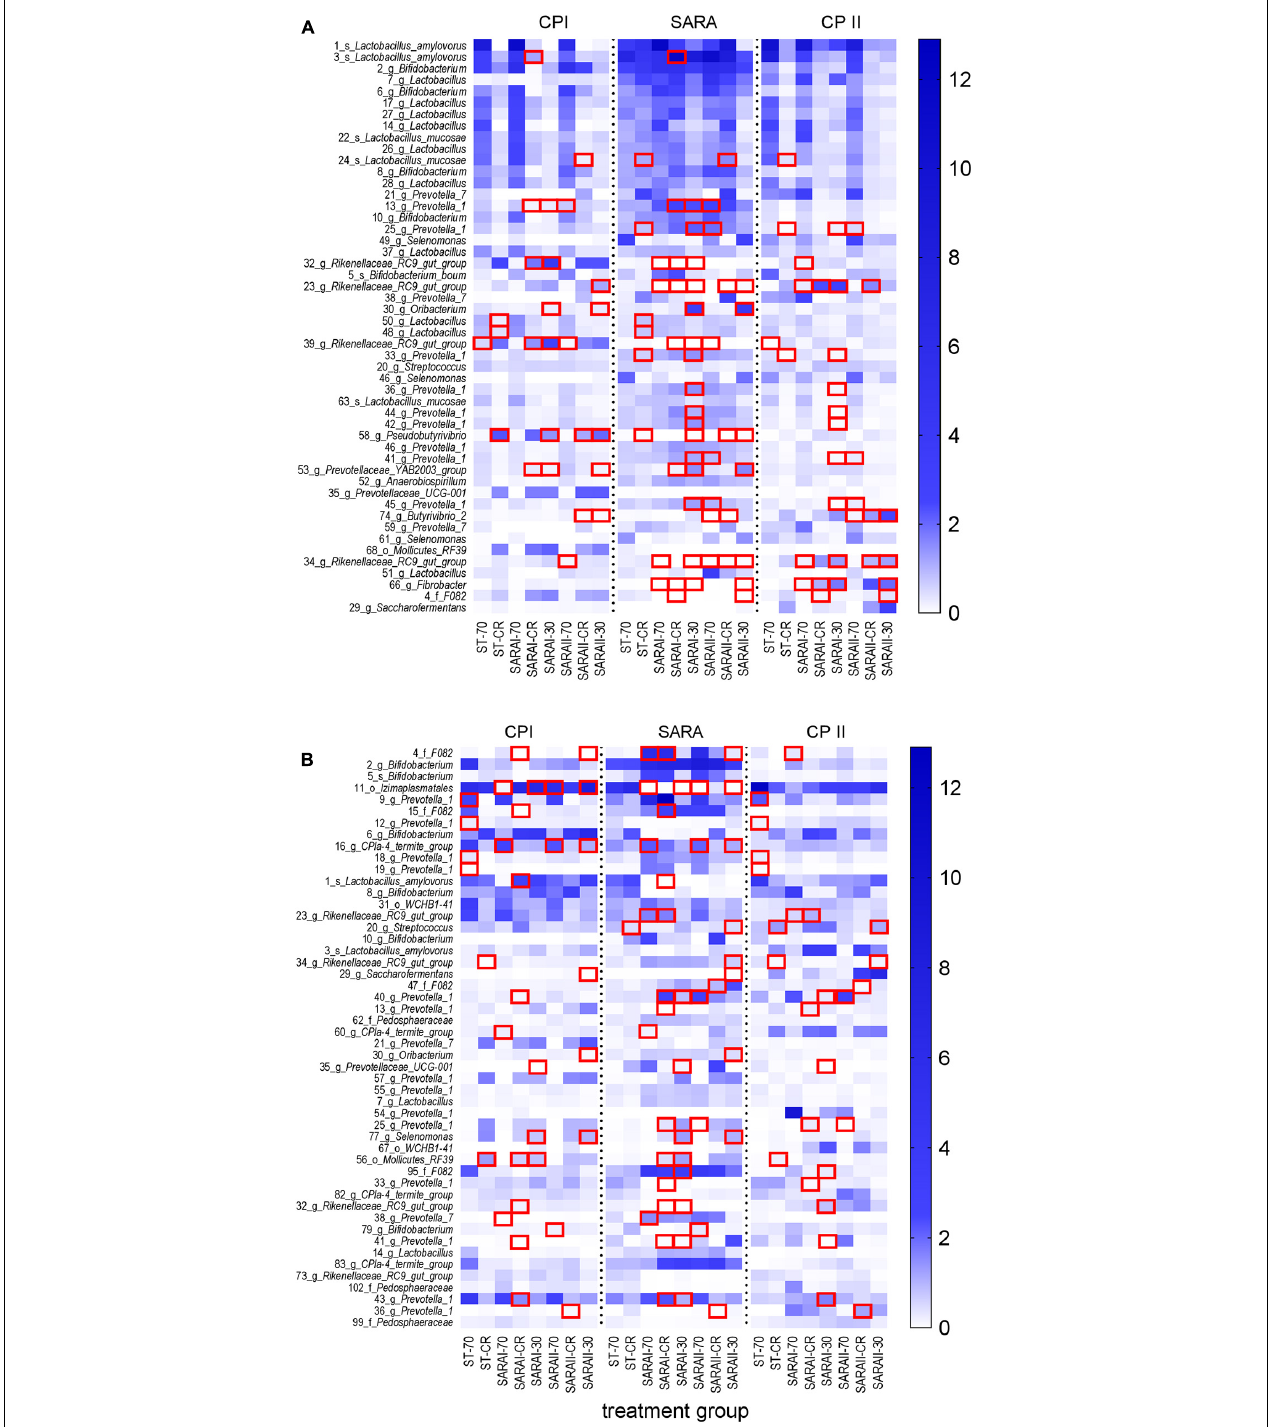
FIGURE 8 | Alterations of the 50 most abundant amplicon sequence variants (ASV) in the PacBio analysis throughout all experimental periods (left: CP I = control period I, middle: AP = acidosis period, right: CP II = control period II) for the solid (A) and liquid (B) phases. ASVs are labeled with the ASV-number, followed by the lowest classification level ( o = order, f = family, g = genus, s = species) and the taxonomic identification. Samples of all four runs were statistically analyzed and are labeled as follows: ST-70 = standard buffer, 70% concentrate; ST-CR = standard buffer, changing ratio; SARAI-70 = SARA I buffer, 70% concentrate; SARAI-30 = SARA I buffer, 30% concentrate; SARAI-CR = SARA I buffer, changing ratio; SARAII-70 = SARA II buffer, 70% concentrate; SARAII-30 = SARA II buffer, 30% concentrate; SARAII-CR = SARA II buffer, changing ratio. The relative abundance (%) is indicated by the color scale. Significant changes of ASVs throughout the three experimental periods are marked with a red